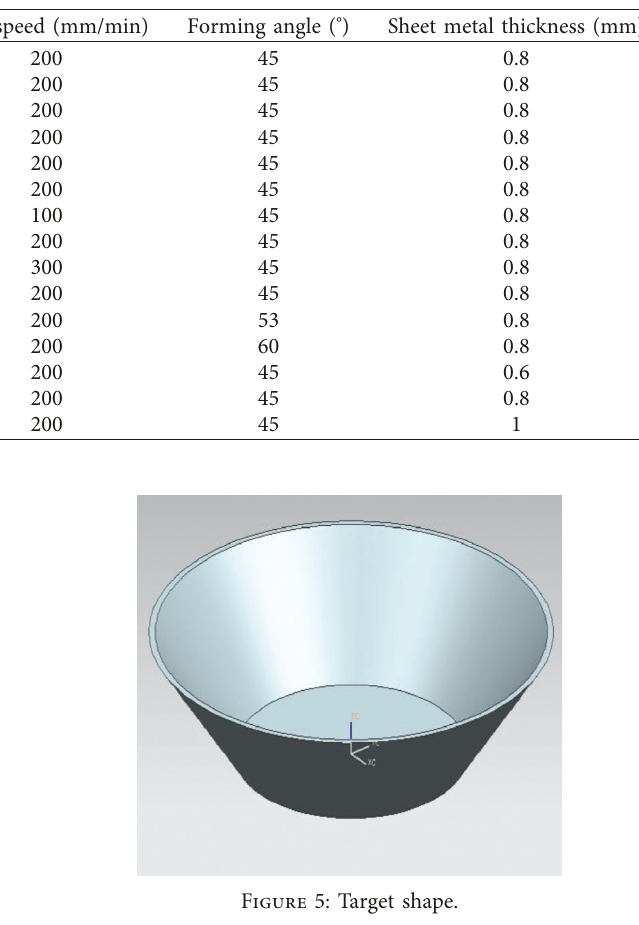
Table 3: Experimental parameter.